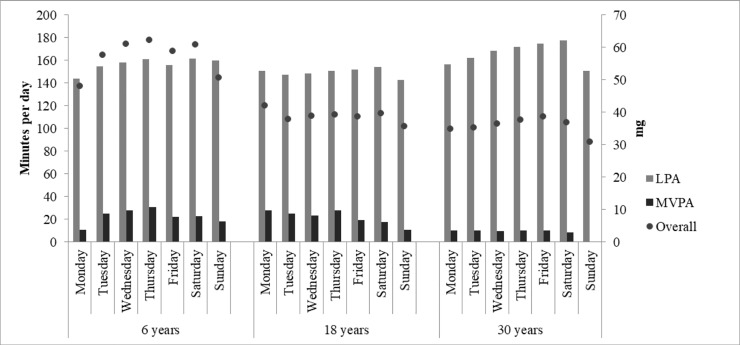
Median of minutes spent in light and moderate-to-vigorous physical activity and overall acceleration (expressed in mg) at 6-, 18- and 30-year-old individuals (number of observations in brackets).